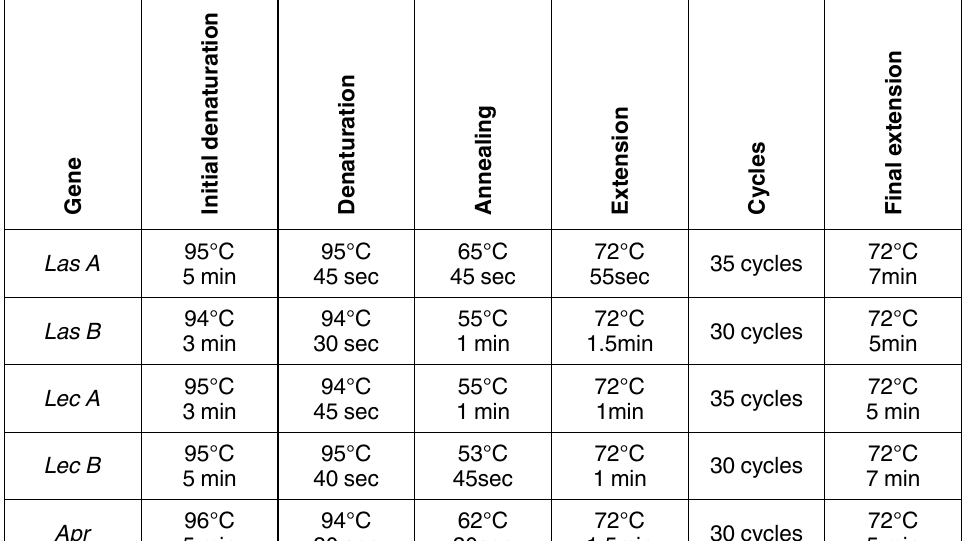
Table 2. Thermocycling conditions for identification of virulence genes by PCR